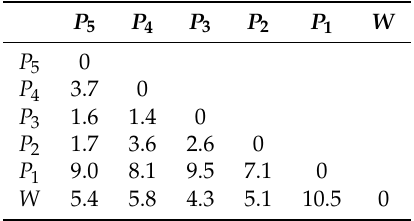
Table 4. Distance matrix in km between the common workplace and residence of all